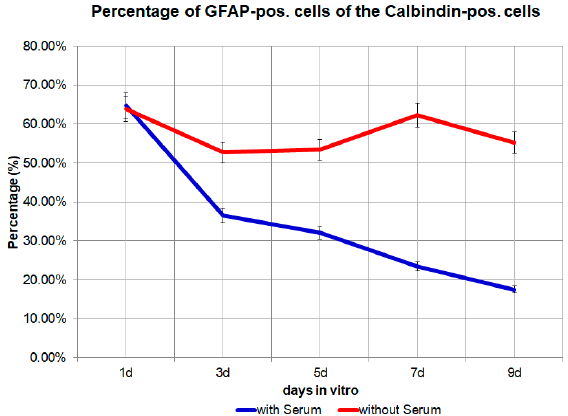
Figure 4. The percentage of Calbindin D28k positive cells of the total cell number from day 1 to day 9 in the medium with 10% FBS or in the medium without FBS. p = 0.0187, significant.